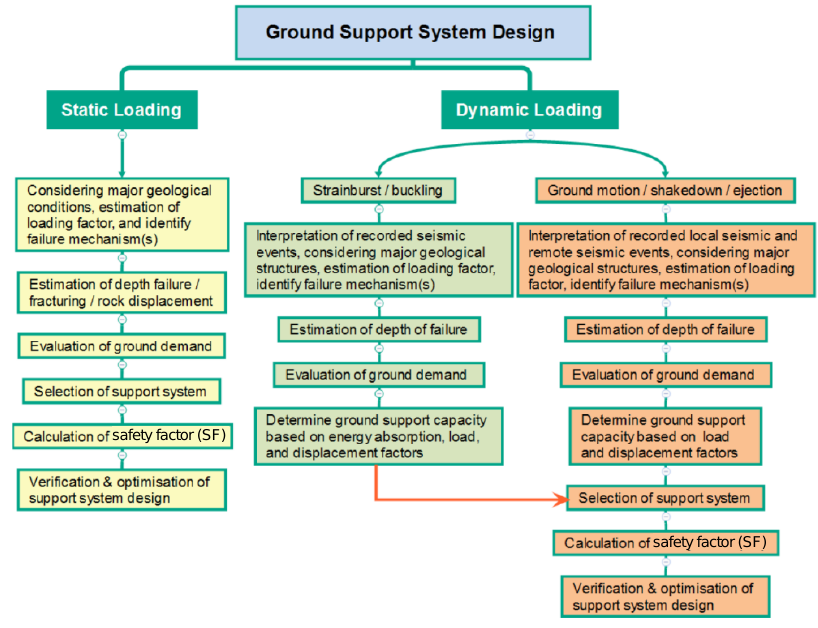
Figure 13. Ground support design in deep underground mines (from [195]).